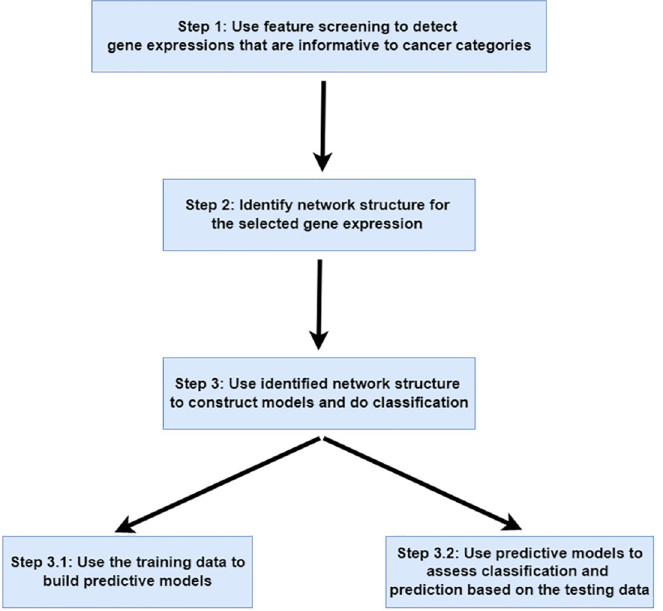
Fig 1. Summary of key steps for the proposed classification method via ultrahigh-dimensional gene